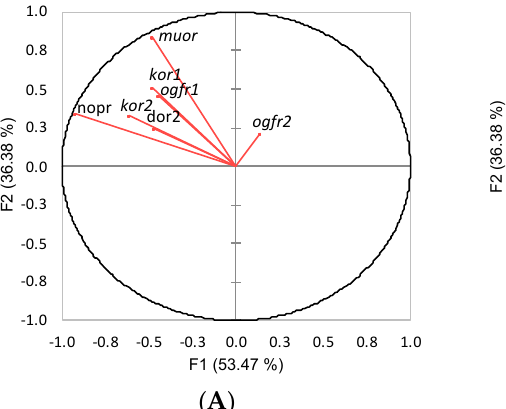
Figure 10. Canonical discriminant analysis of European seabass telencephalic expression of opioid receptor genes. ( A ) Correlation variables/factors (factor loads) for two main discriminant functions (F1 and F2); muor , mu opioid receptor; kor1 , kappa opioid receptor 1; kor2 , kappa opioid receptor 2; dor2 , delta opioid receptor 2; ogfr1 , opioid growth factor receptor 1, ogfr2 , opioid growth factor receptor 2; nopr , nociceptin opioid receptor. ( B ) Canonical discriminant scores of each group. Group centroids are marked by a small diamond, whereas circles indicate data distribution per group.